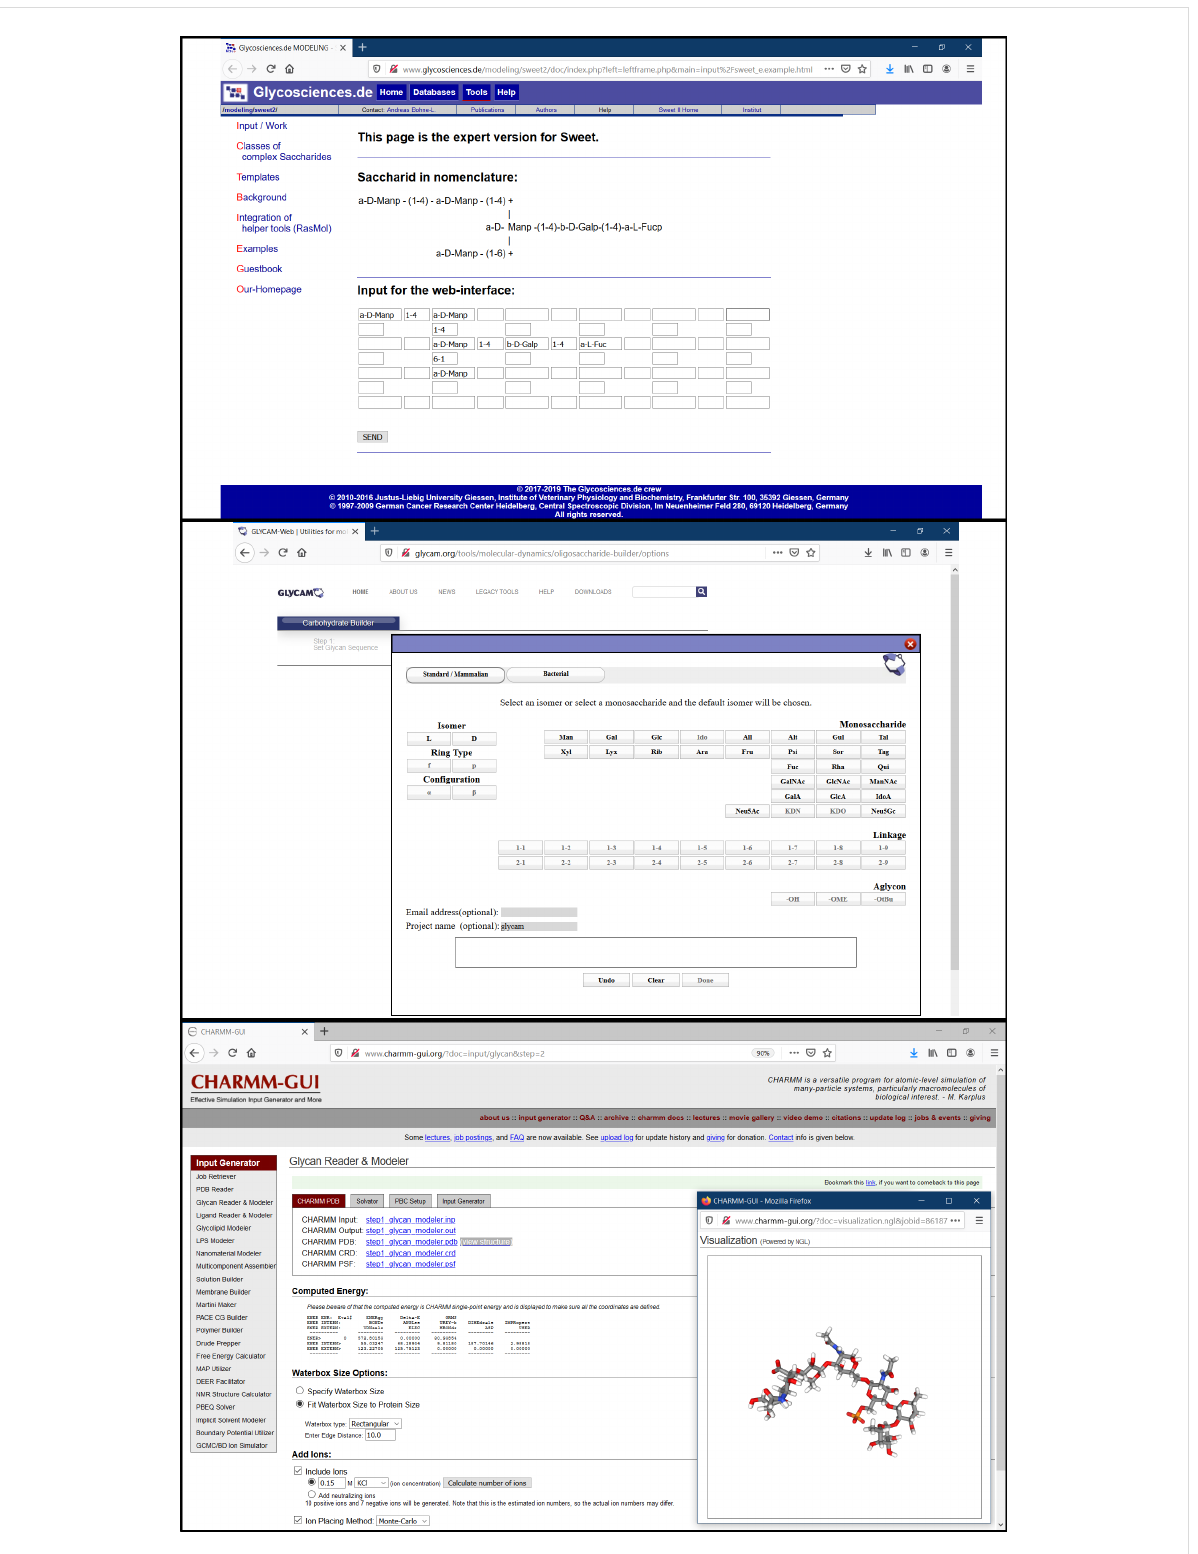
Figure 9: From top to bottom: Sweet II [62] web-interface with a text input to generate a 3D model. GLYCAM Carbohydrate Builder [63] interface which accepts a text input for glycans and generates 3D models. CHARMM-GUI (Glycan reader and Modeler) [64] interface with a 3D structure output generated using a glycan sequence as